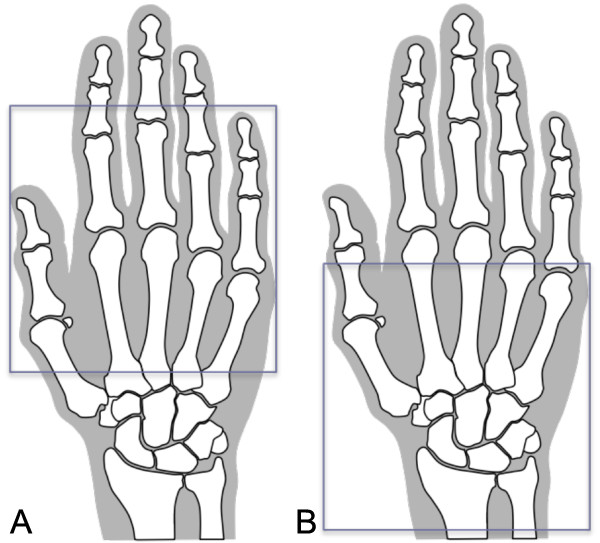
Positioning of surface coil for magnetic resonance imaging of metacarpophalangeal and proximal interphalangeal joints (A) and wrist joints (B). Because of limited field of view of surface coils available at the sites acquiring images for this study, two separate scans (A, B) were required to cover the hand and wrist completely.